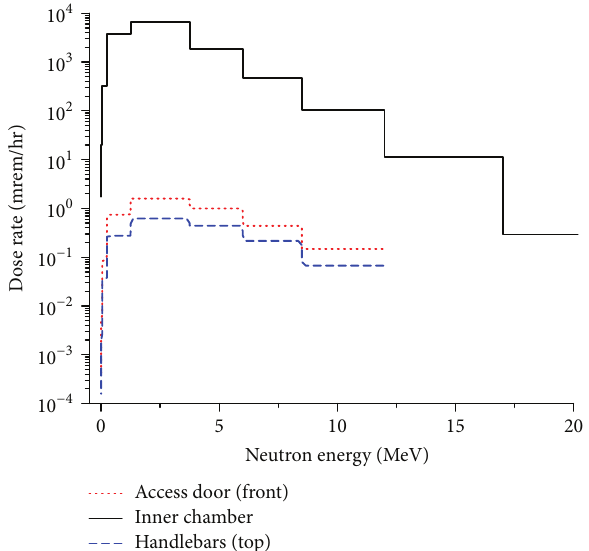
Figure7:Neutrondoseratestowaterphantomsatvariousirradiator